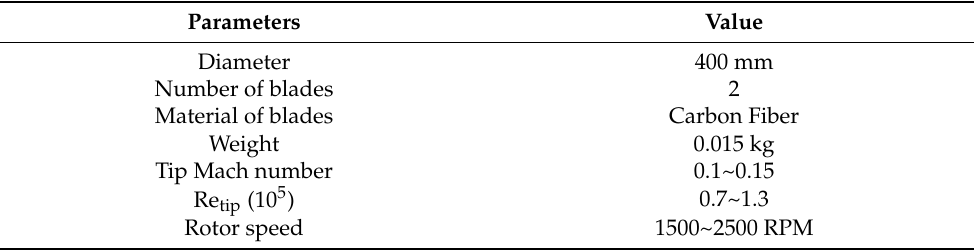
Figure 3. Experimental setup ( a ) rotor configuration; and ( b ) sketch of setup. Table 1. Parameters of rotor.